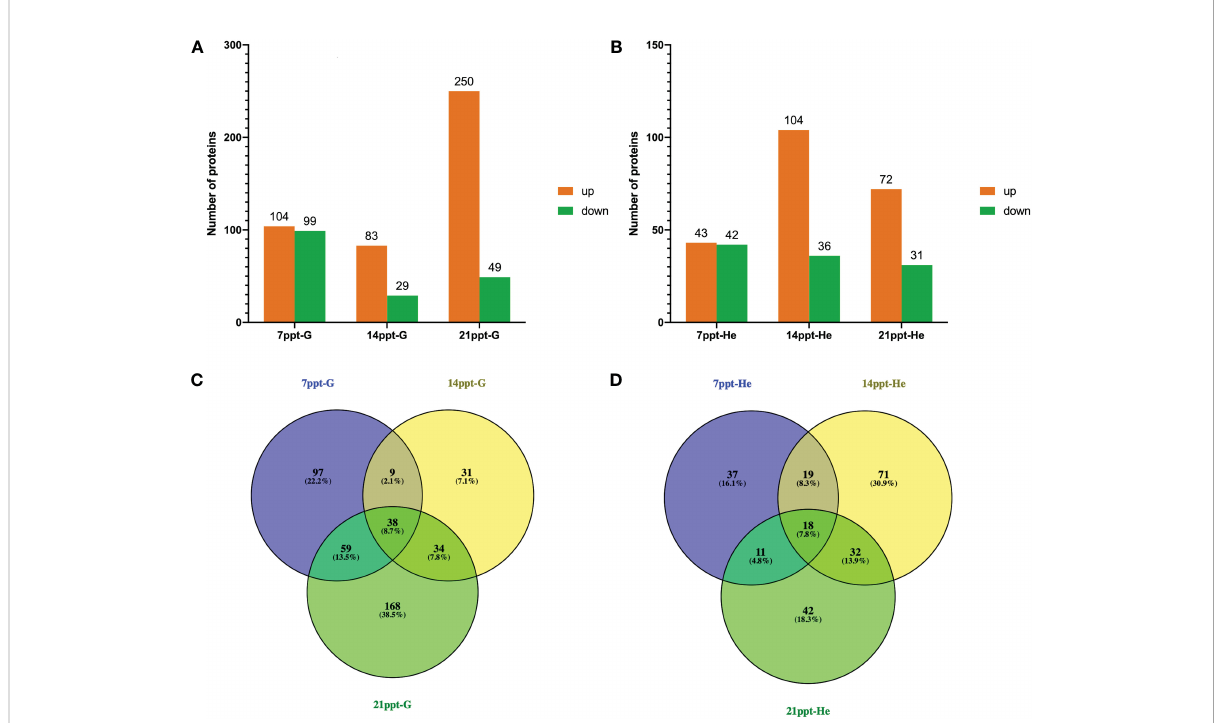
FIGURE 10 Statistic of DEPs numbers in the gills ( A : 7 ppt-G, 14 ppt-G, 21 ppt-G) and hepatopancreas ( B : 7 ppt-He, 14 ppt-He, 21 ppt-He). Venn diagram of DEPs of M. nipponense in 7, 14 and 21ppt salinity treatment comparisons in the gills ( C : 7 ppt-G, 14 ppt-G, 21 ppt-G) and hepatopancreas ( D : 7 ppt-He, 14 ppt-He, 21 ppt-He).